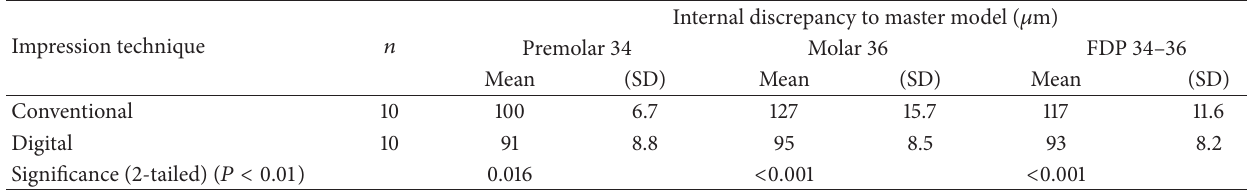
Table 1: Mean internal discrepancy in 𝜇 m and standard deviation (SD) between abutment surface and inside surface of FDP produced with conventional and digital impression techniques.